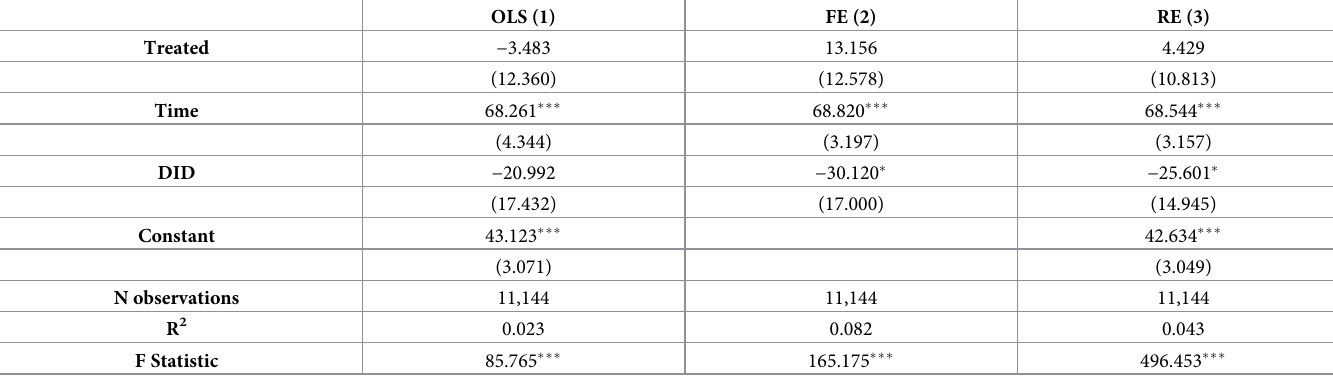
Table 8. Difference-in-differences average agriculture, GVA results: Pooling, fixed-effects, and random-effects .